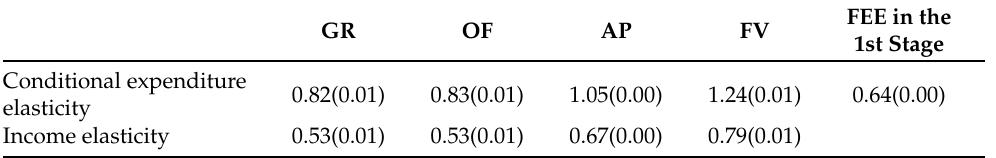
Table 3. Estimated conditional expenditure elasticity and income elasticity among the elderly population. GR OF AP FV